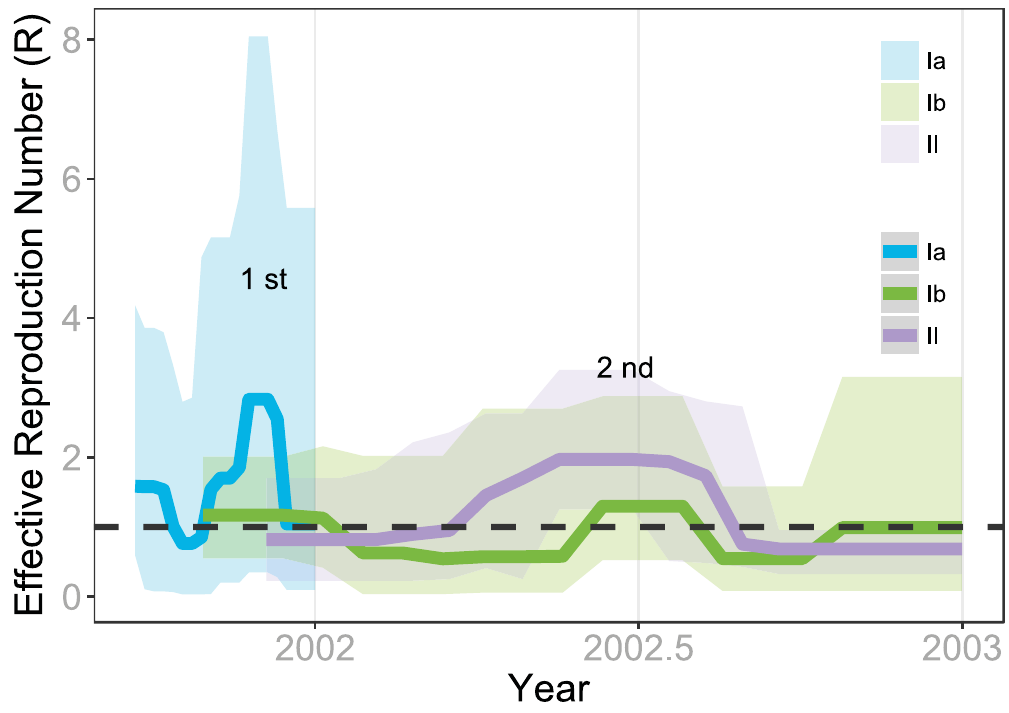
Fig 6. Viral transmissibility of the three groups of DENV-2 variants measured by effective reproductive number (R). The R (solid line) values and 95% HPD interval (shaded area) from 2001 to 2003 of three DENV-2 viral variants were estimated by birth-death skyline serial analysis. The plot clearly demonstrates that the two peaks of viral transmissibility corresponded well with the two peaks of confirmed DENV-2 cases from 2001 to 2003. The R values of both group Ia and Ib variants surpassed 1.00 during 2001. They were replaced by group II variants when R surged in early 2002, accompanied by the recurrence of group Ib variants.